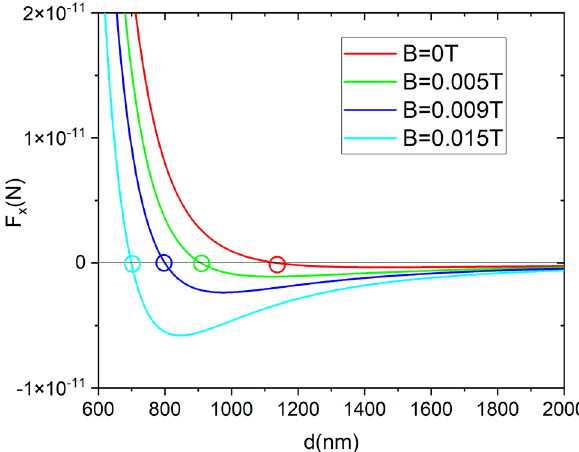
Figure 6. Force versus interparticle distance for several values of the external magnetic field in the case of 200 nm radius InSb particles illuminated with a plane wave of wavelength (cid:31) = 47.97 µ m, polarization angle arctan ( √ 2 ) and intensity 25 µ W / nm 2 . Empty circles mark the equilibrium distances for each magnetic θ = field.